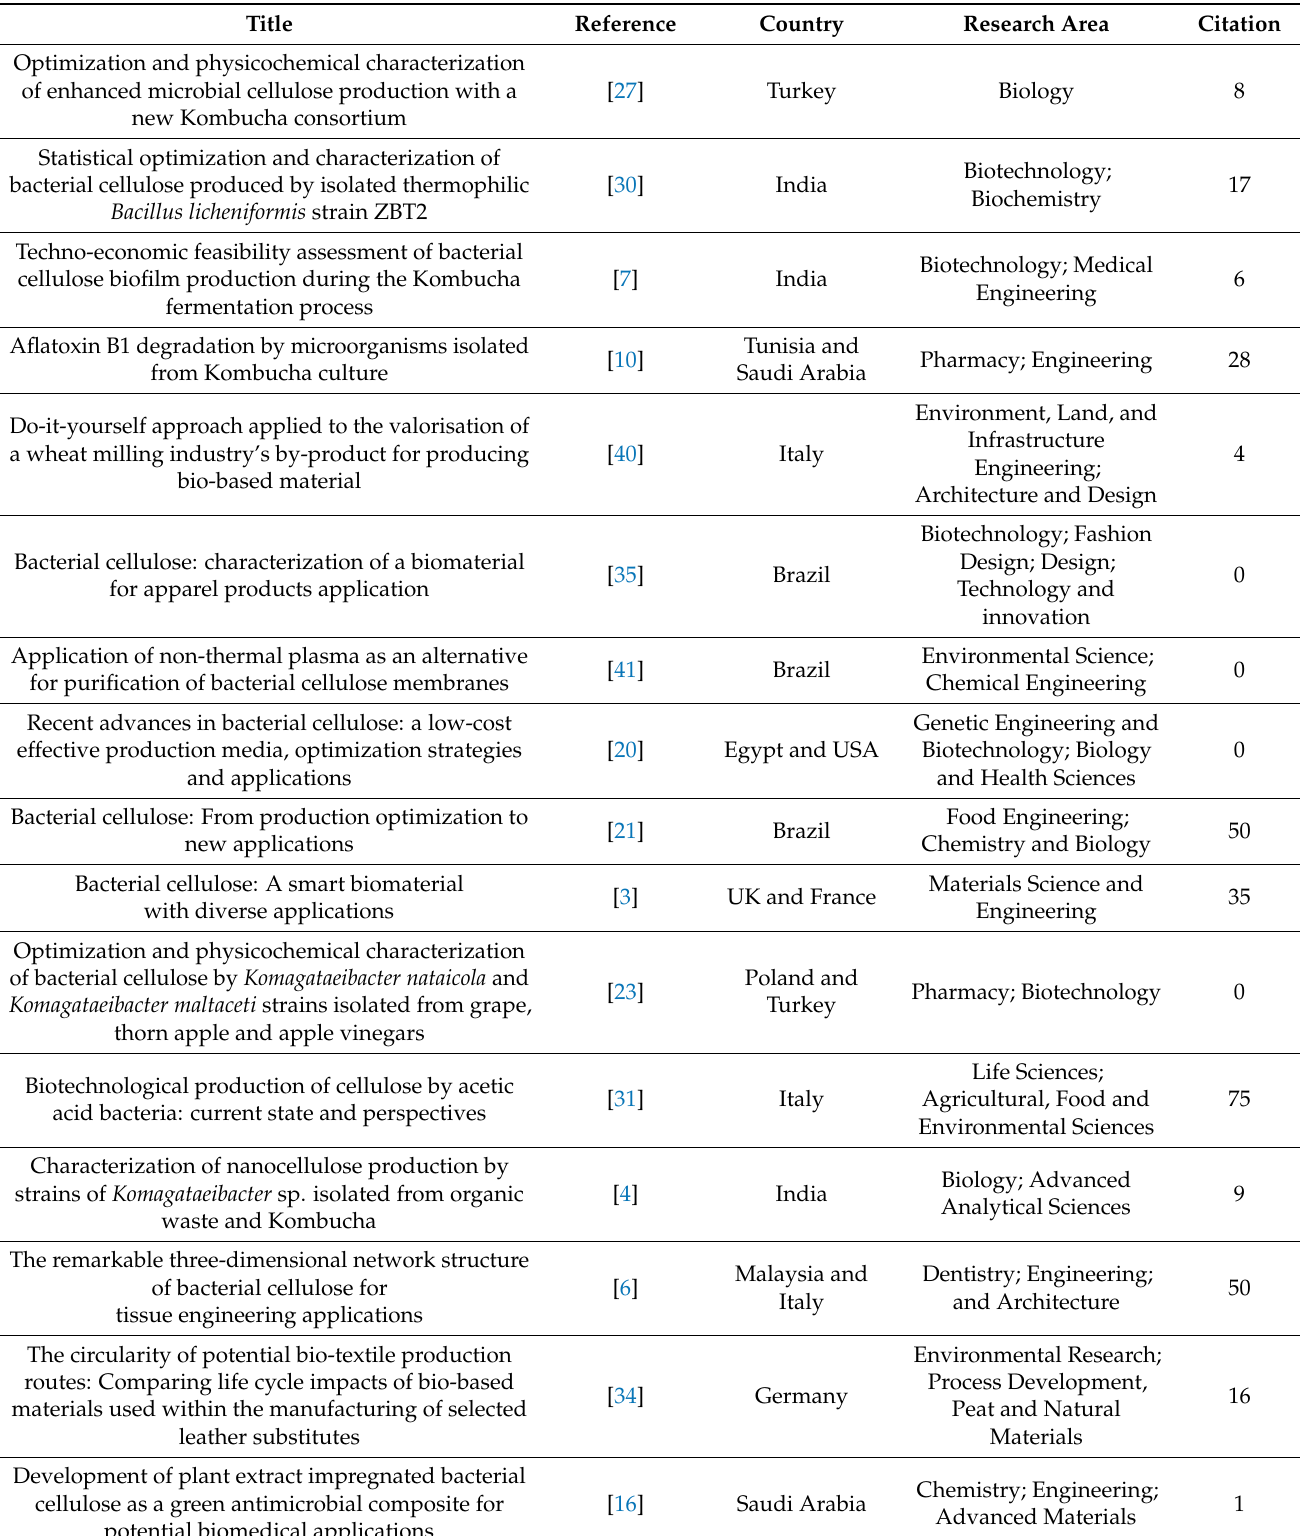
Table A1. Specific details of the research and review articles used to write this